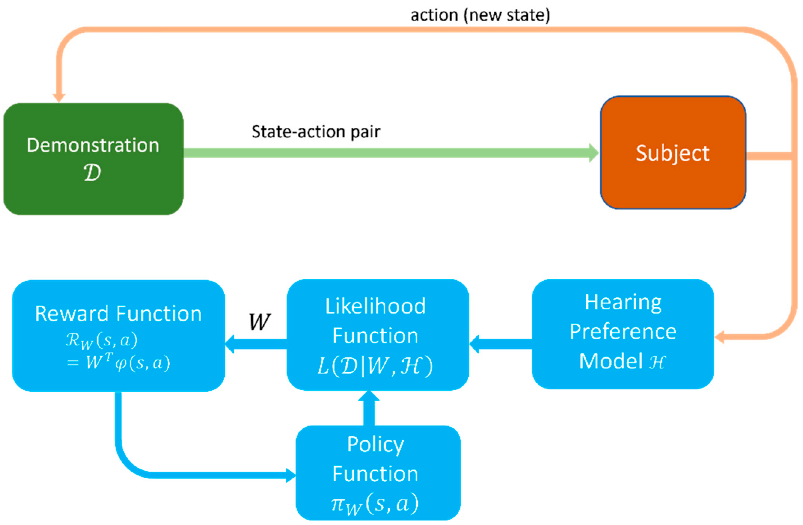
Figure 6. Components of the MLIRL personalization method.